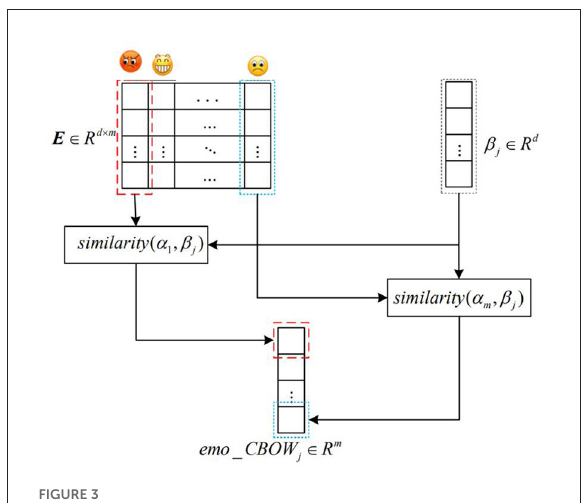
FIGURE3 Word vector construction diagram integrating